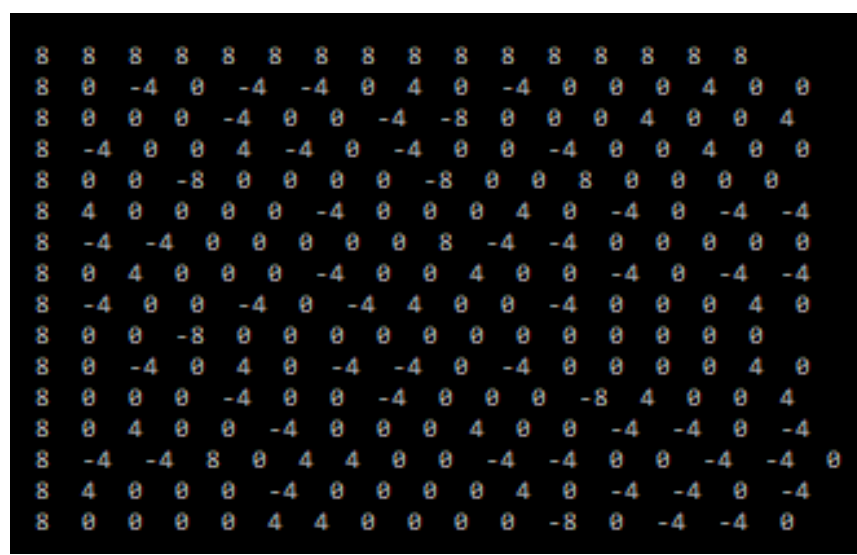
Figure 7. C++ experimental results of